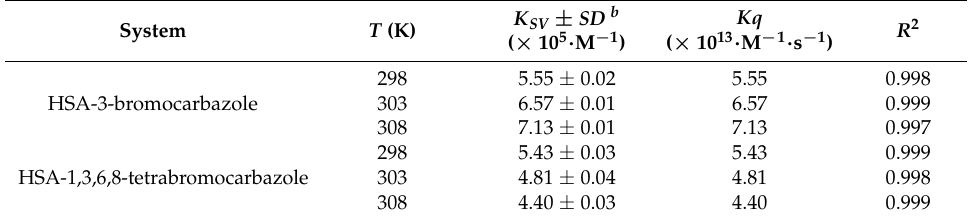
Stern-Volmer quenching constants for the interactions of 3-bromocarbazole